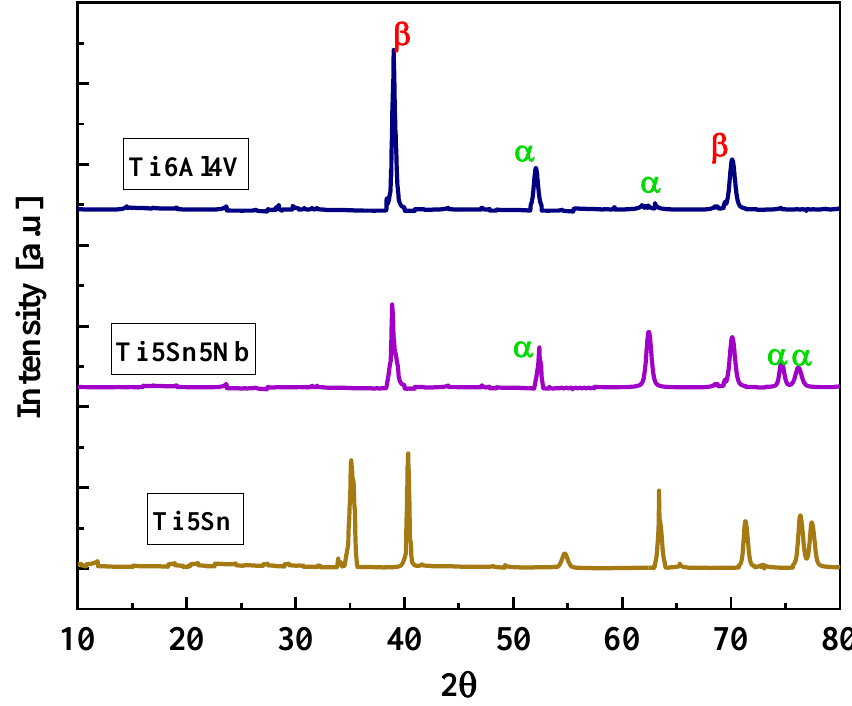
Figure 5. Diffracted peaks of Ti5Sn, Ti5Sn 5Nb and, Ti6Al4V. Brown line indicates Ti6Al4V. Purple line shows Ti5Sn5Nb, and pink line represents Ti5Sn.